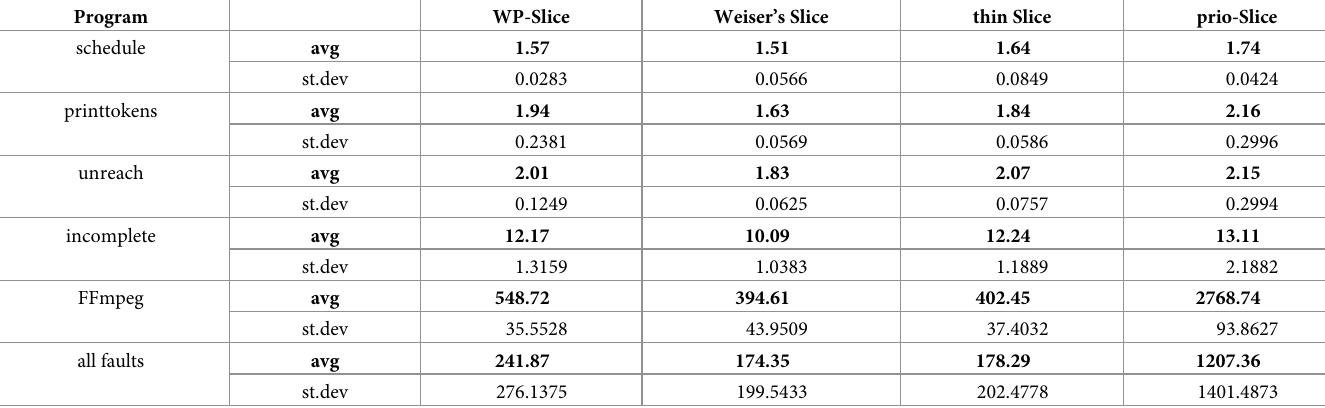
Table 4. Statistics for slice time of WP-Slice, weiser’s slice, thin slice and prio-slice in